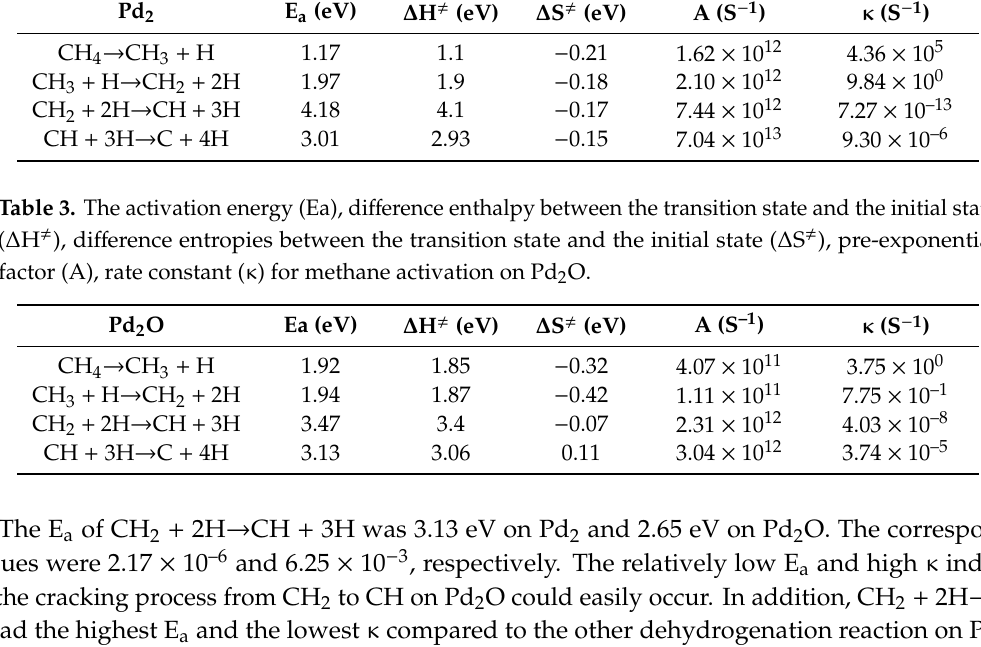
Table 2. The activation energy (E a ), di ff erence enthalpy between the transition state and the initial state ( ∆ H (cid:44) ), di ff erence entropies between the transition state and the initial state ( ∆ S (cid:44) ), pre-exponential factor (A), rate constant ( κ ) for methane activation on Pd 2. Pd 2